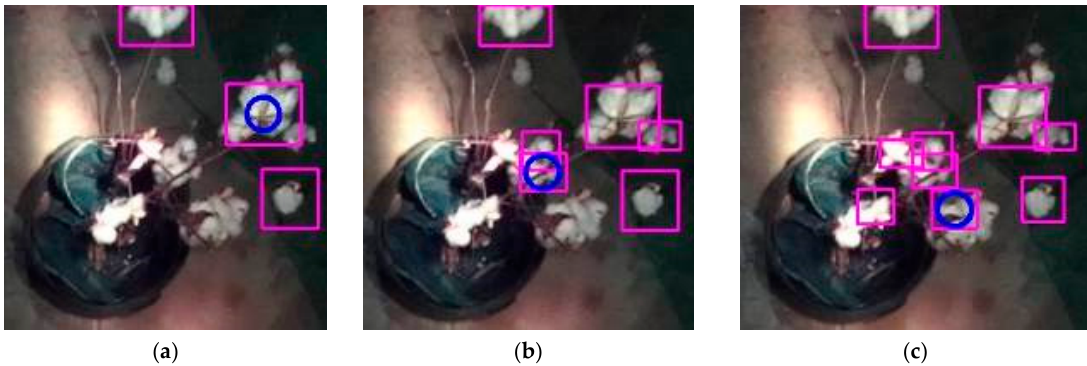
Figure 8. Detection of cotton bolls: ( a ) using bilinear transformation, 3 bolls were detected; nearest-neighbor interpolation ( b ) detected 5 bolls; and ( c ) without interpolation detected 8 bolls. The pink boxes are bounding boxes of the detected bolls, while blue represents the nearest boll to be picked.